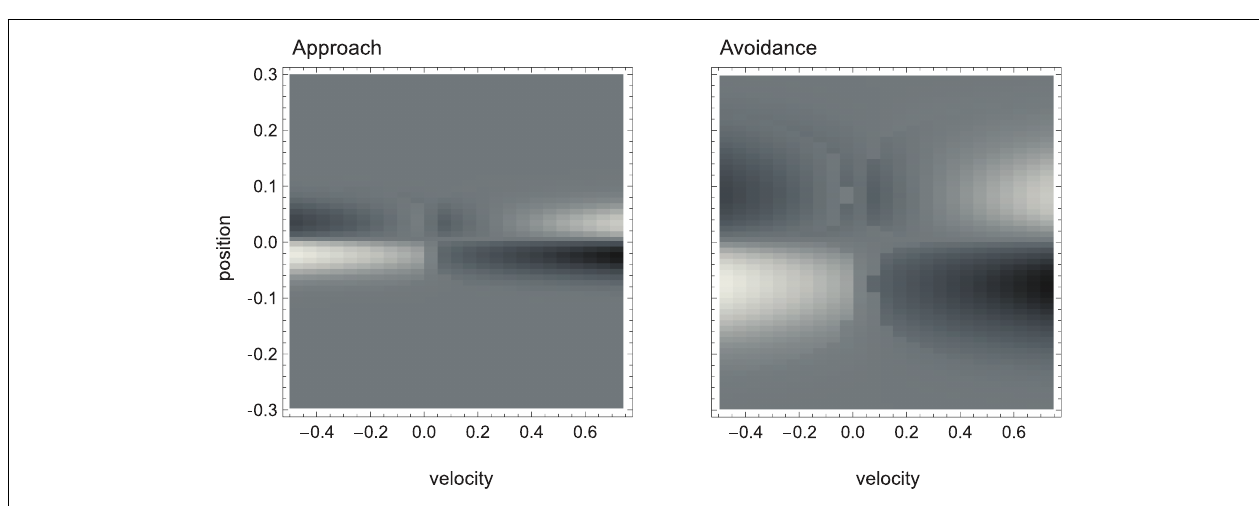
FIGUREA5 | Sensorimotor habitat . Change in sensory reading as agent moves a small proportion from its initial position and velocity toward its steady-state velocity. Bright areas indicate increased, dark areas reduced sensor